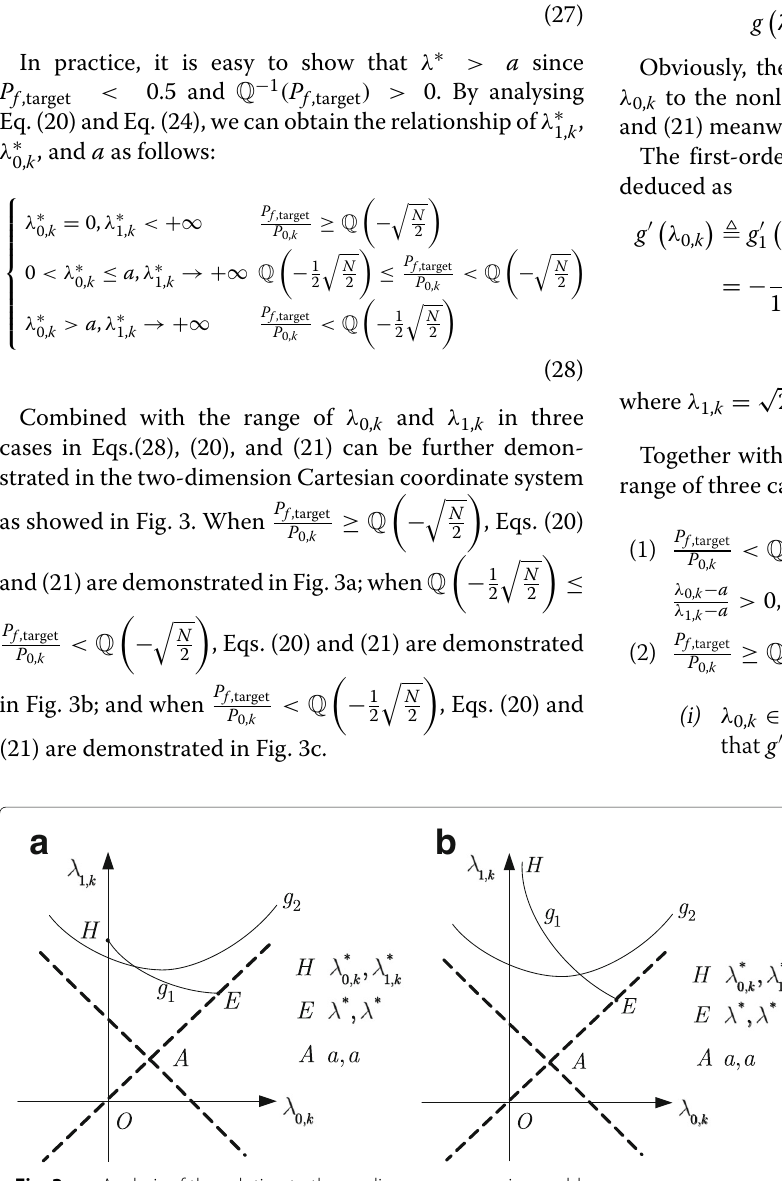
Fig. 3 a – c Analysis of the solution to the nonlinear programming